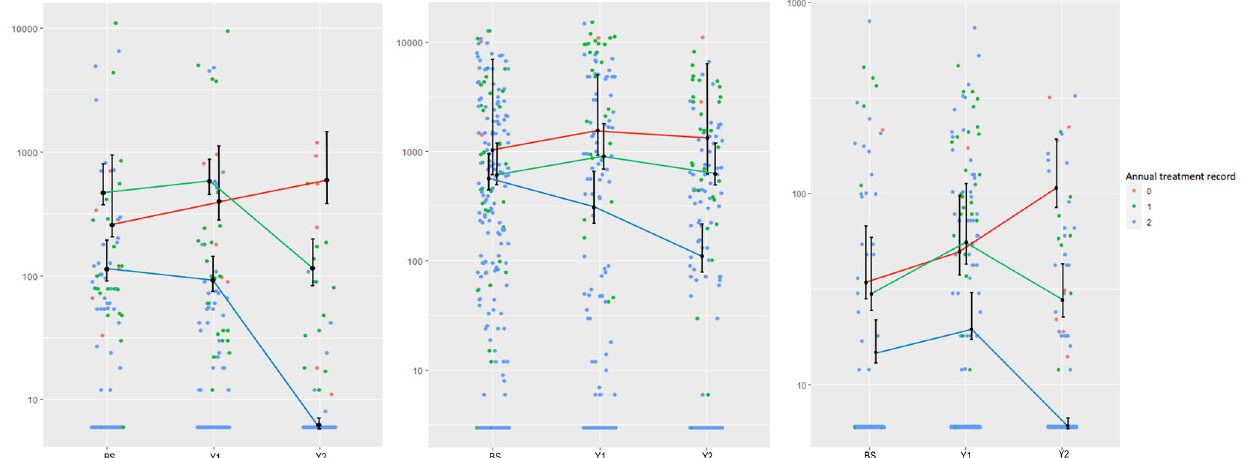
Fig 5. Scatter plot showing individual level intensity data of infected individuals in baseline, Year 1 and Year 2 surveys stratified by STH species; A . T . trichiura , B . A . lumbricoides and C . Hookworm. Each ribbon represents trend representing the mean EPG and 95% confidence limits of the mean based on the assumption of a negative binomial distribution of the epg data, of never (fully non-compliant), single (partially compliant) and two annual treatment (fully compliant) individuals.